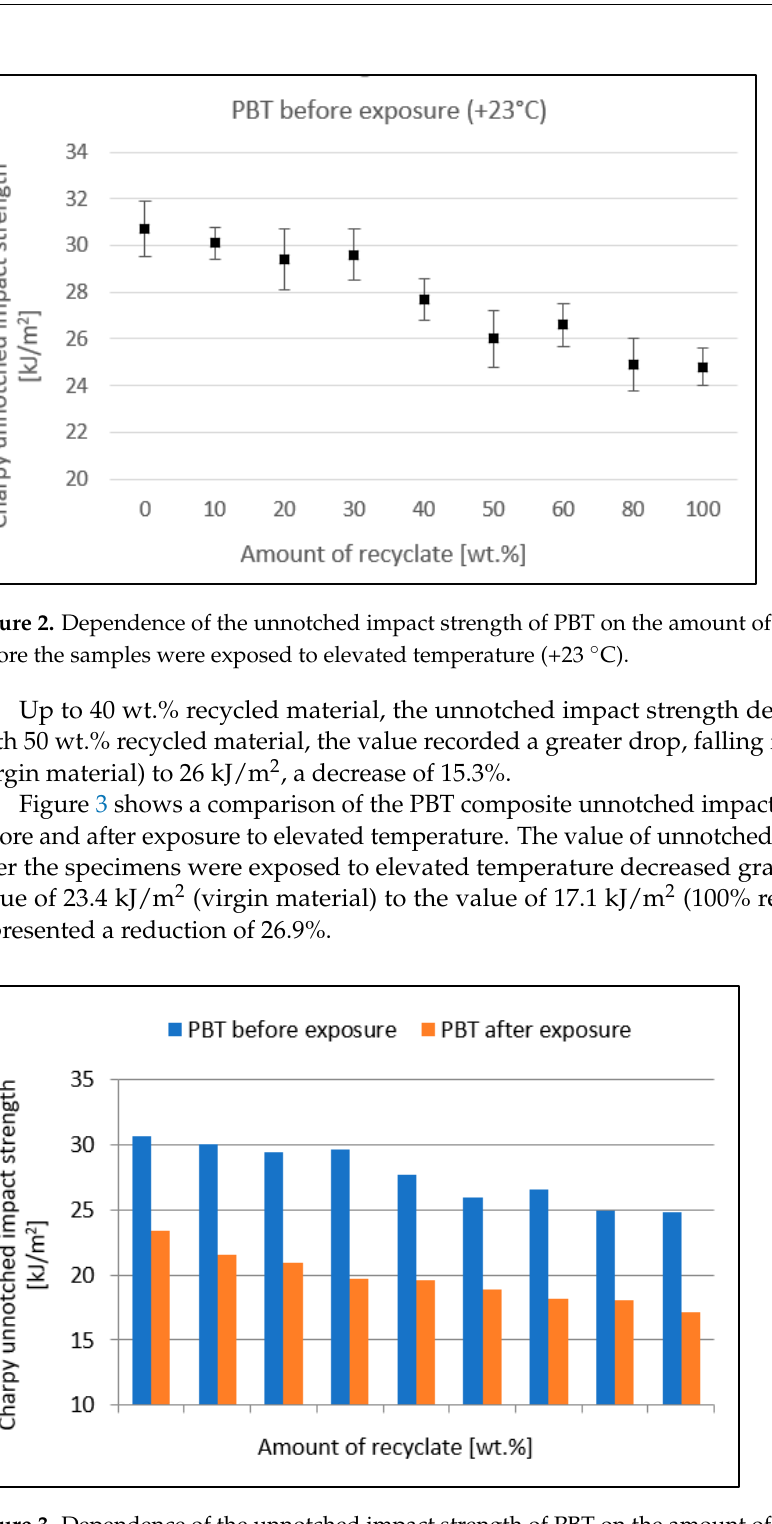
Figure 3. Dependence of the unnotched impact strength of PBT on the amount of recycled material before and after the samples were exposed to elevated temperature (+23 °C).